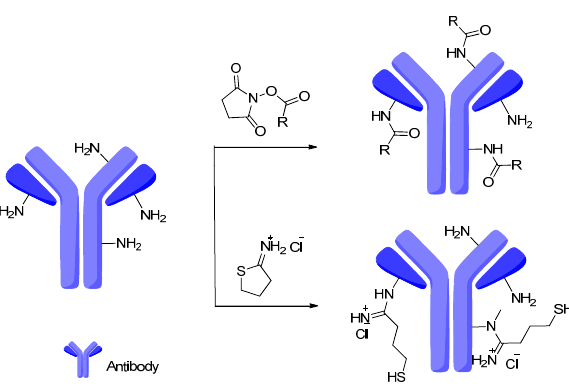
Figure 14. The amines of lysines on the antibody react with N -hydroxysuccinimide (NHS) esters forming the amides and react with Traut’s reagent forming the amidines.